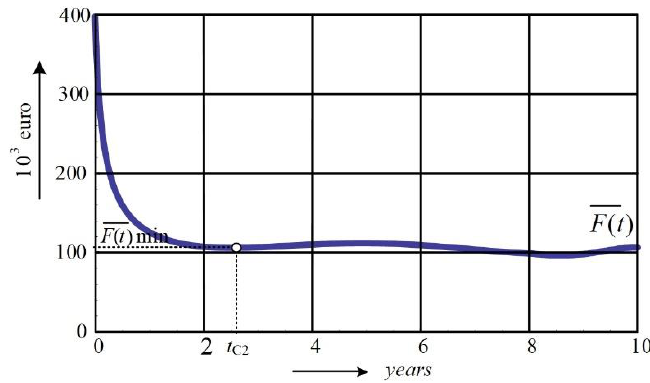
Figure 8. The function of average costs for the machine type 2.